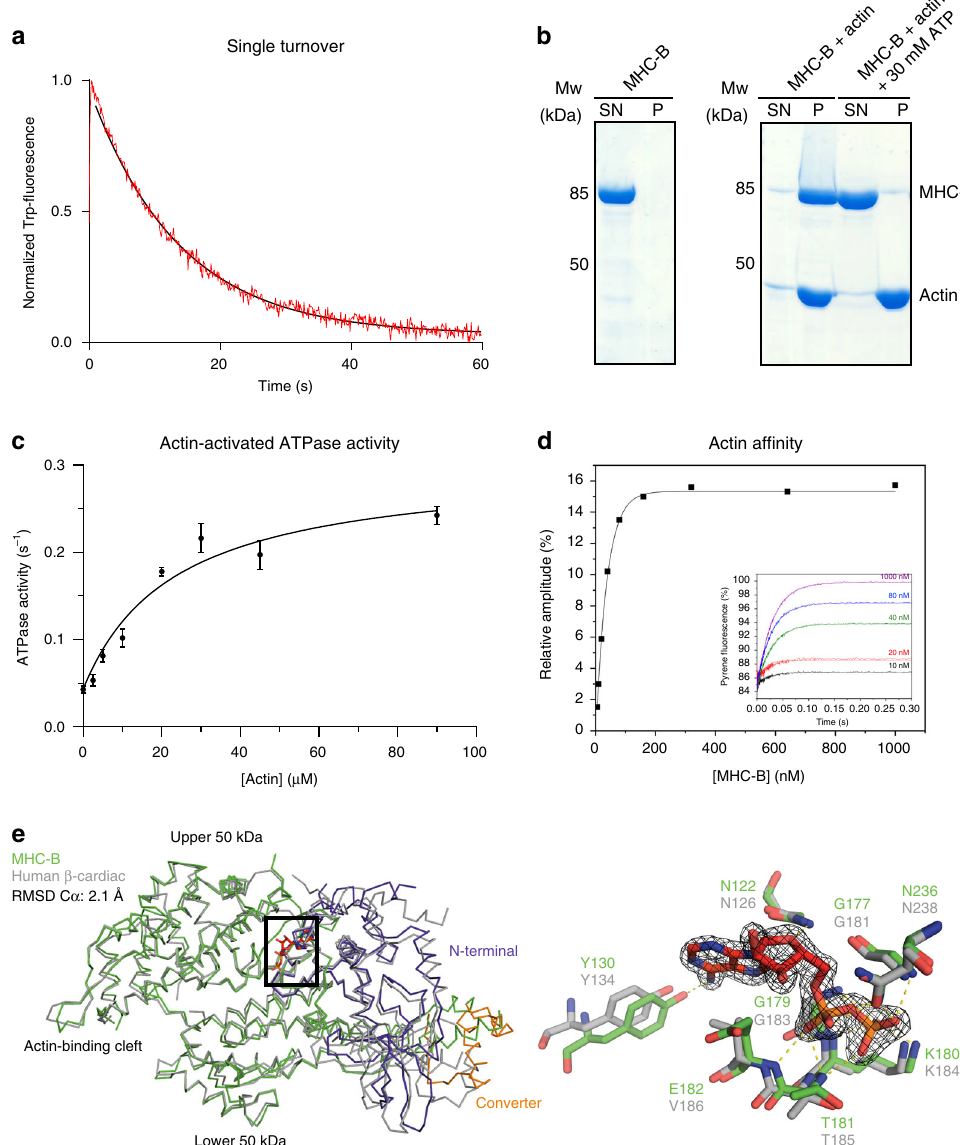
Fig. 3 Characterization of functional MHC-B. a Single ATP turnover experiment monitoring Trp- fl uorescence decay ( K obs = 0.073 s − 1 ). b F-actin co- sedimentation assay. In the presence of F-actin, MHC-B is detected in the pellet fraction (P) but is released upon addition of ATP and found in the supernatant (SN). c F-actin-stimulated ATPase activity of MHC-B, yielding V max = 0.257 s − 1 and K M = 23.1 µ M. Error bars represent the s.e.m., of two biological replicates (MHC-B from different puri fi cations), for which three technical replicates have been carried out each. d Stopped- fl ow analysis measuring dissociation of the actin:MHC-B complex. The inset illustrates example traces of the increase in pyrene fl uorescence when 20 µ M ATP was mixed with 50 nM pyrene-labelled actin and varying concentrations of MHC-B (5 – 1000 nM). The increase in fl uorescence can be described by an exponential function in which the rate constant is proportional to the ATP concentration and the amplitude of the fl uorescence change is proportional to the fractional saturation of actin with MHC-B. The actin af fi nity derived by this experiment was 10.3 ± 3.7 nM (average of three independent measurements). e Left panel: Structural alignment of ADP(red)-bound MHC-B (50 kDa domain in green, N-terminal domain in lilac, converter in orange) and human beta-cardiac myosin (PDB code: 4db1, gray). Right panel: Close-up view of the nucleotide-binding pocket of MHC-B in the ADP-bound state, overlaid with corresponding active site residues of the cardiac myosin. The ADP molecule (red) is shown together with the 2Fo-Fc omit electron density, contoured at 1.5